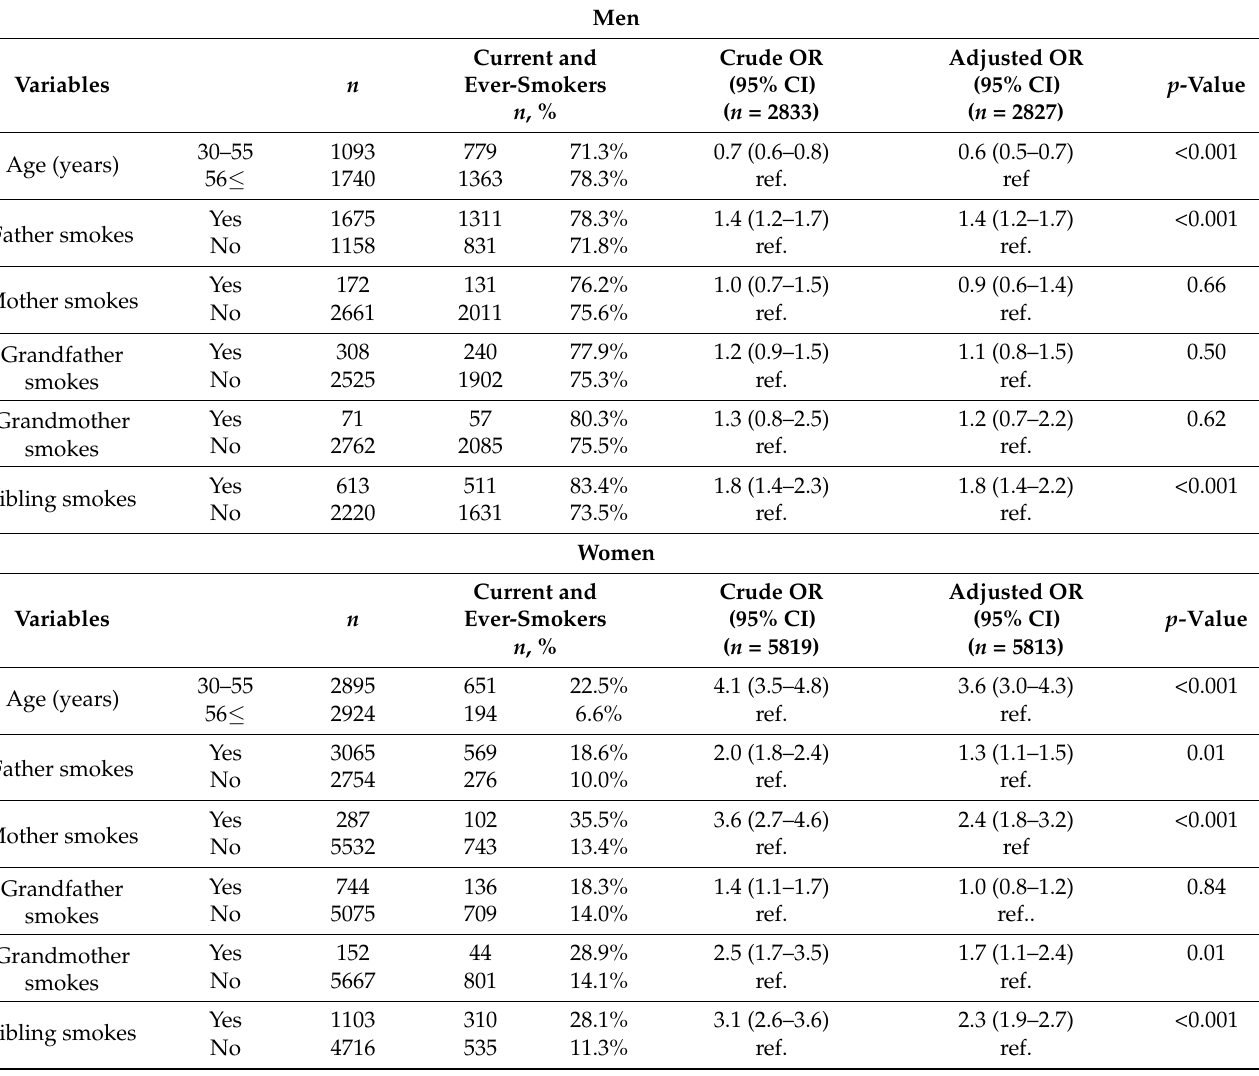
Table 2. Gender differences in smoking initiation.